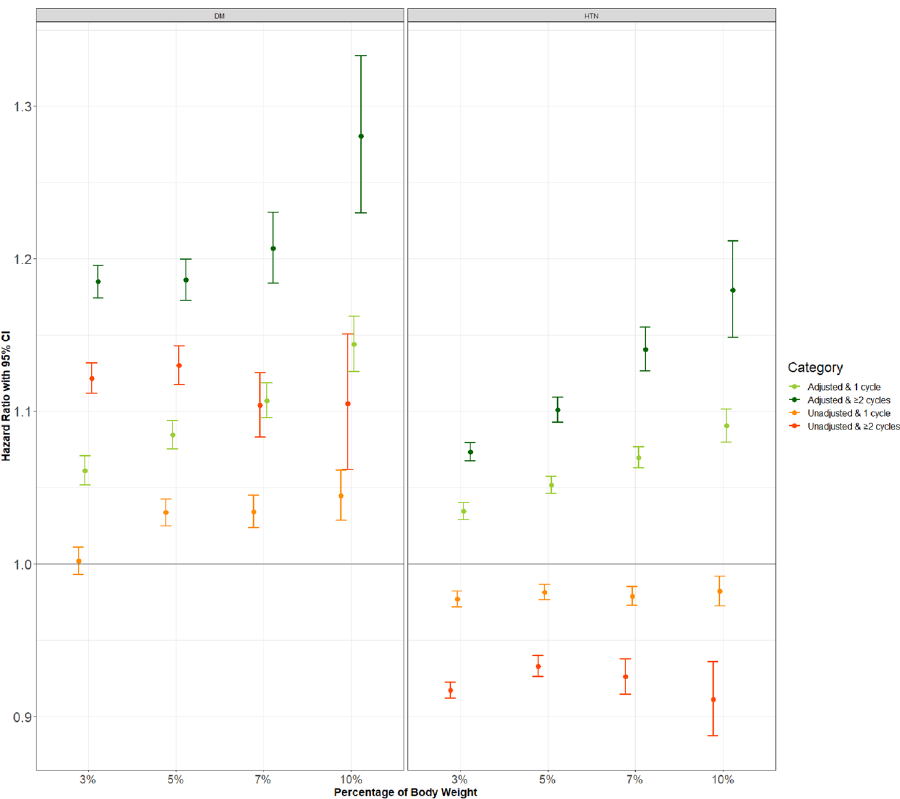
Figure 1. The association between body weight cycling and the risk of type 2 diabetes and hypertension according to various definitions of body weight cycling. Incident diabetes was defined as the prescription of antidiabetic medication or fasting blood sugar ≥ 126 mg/dL. Hypertension was defined as the prescription of hypertensive medication or systolic or diastolic blood pressure ≥ 140/90 mmHg. The hazard ratio was calculated with a Cox proportional hazards regression without adjustment (left, a ) and with adjustment for age, sex, body mass index, systolic blood pressure, fasting blood sugar, total cholesterol, smoking status, alcohol consumption, physical activity, past medical and family history (right, b ). Dots and error bars indicate the hazard ratio and 95% confidence interval,